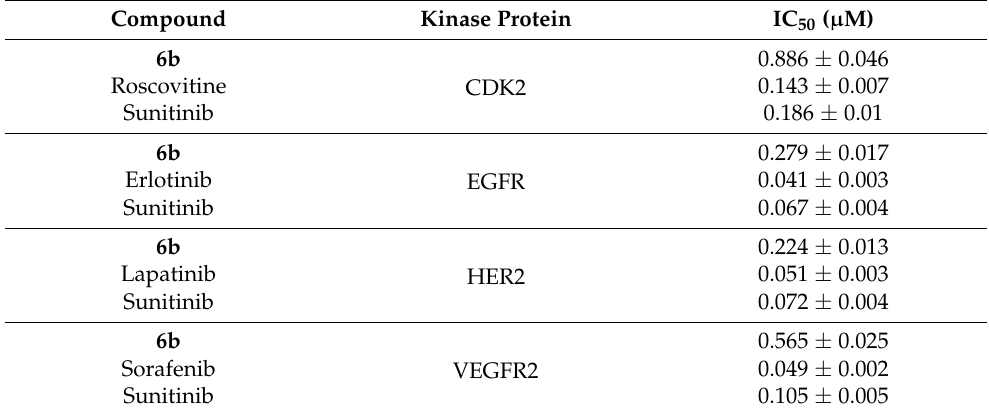
Table 3. The inhibitory effect of compound 6b on the kinase proteins (CDK2, EGFR, HER2, and